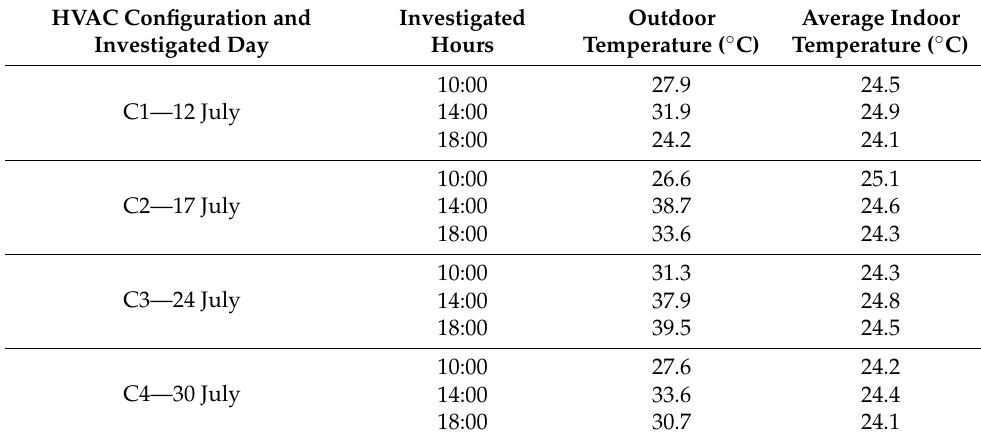
Table 6. Investigated hours: outdoor temperature and average indoor